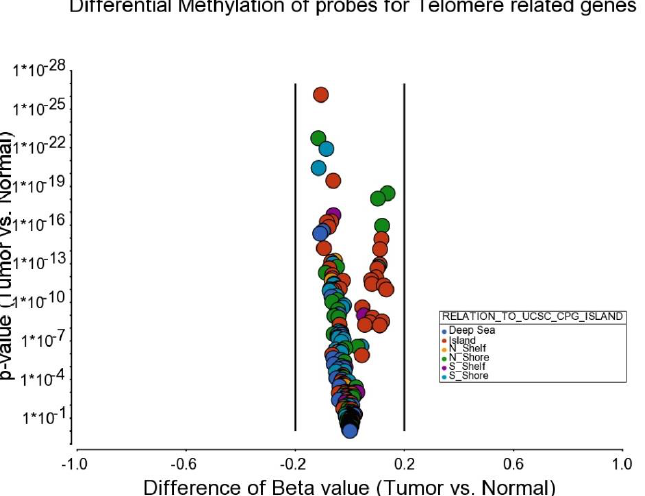
Figure 10. Volcano plot showing the probe-level differential methylation data of telomere-related genes in CRC tissue compared to corresponding normal tissue. Magnitude of difference (beta value of CRC minus beta value of normal tissue) is shown on the x-axis, and the p -value from paired t-test is shown on the y-axis. The location of the probes in relation to the CpG island are color-coded.